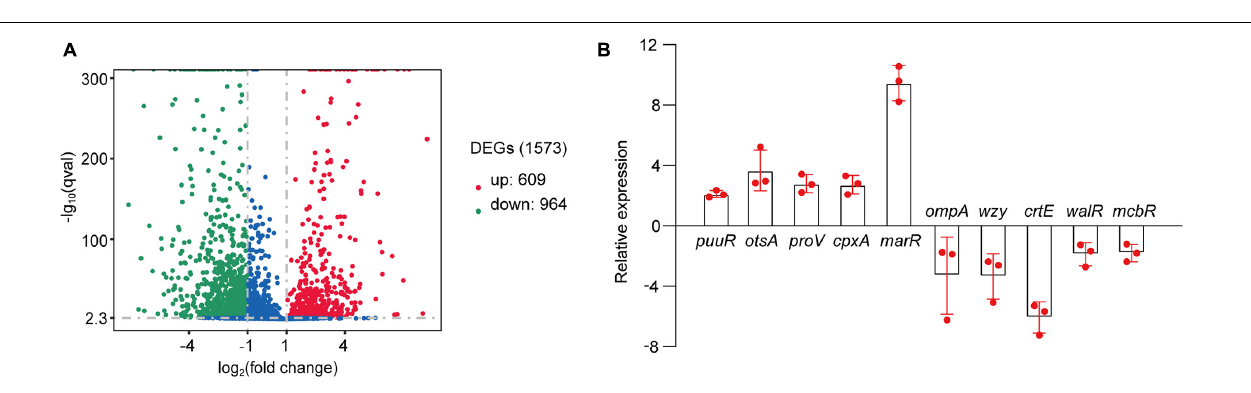
FIGURE 3 | Transcriptome analysis. (A) Volcano plots of upregulated and downregulated ( ≥ 2-fold) mRNAs in desiccated C . sakazakii G4023. The red dots represent upregulated genes, green dots represent downregulated genes, and blue dots represent no significantly differentially expressed gene. (B) Confirmation of the RNA-seq results by qRT-PCR analysis; the expressions were normalized with the internal control gene glnS . The qRT-PCR fold-change tendencies agreed with the RNA-seq results. The error bars represent mean ± SD; n =